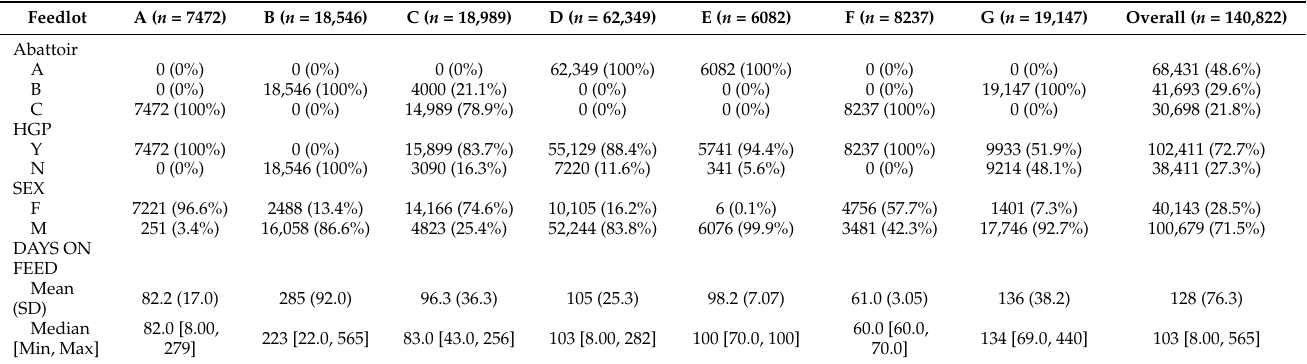
Table 1. Number of carcasses with attributes across seven feedlots and three processing